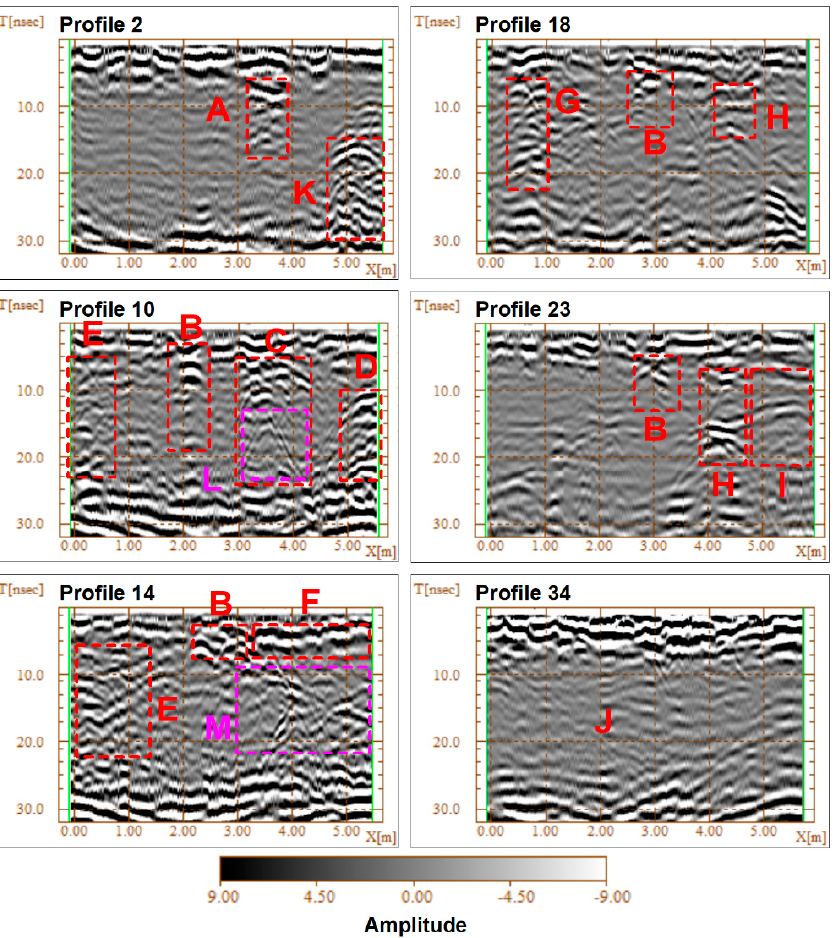
Figure 5. Indication of anomalies on selected transversal radargrams from the entire data set relative to the frequency of 600 MHz.